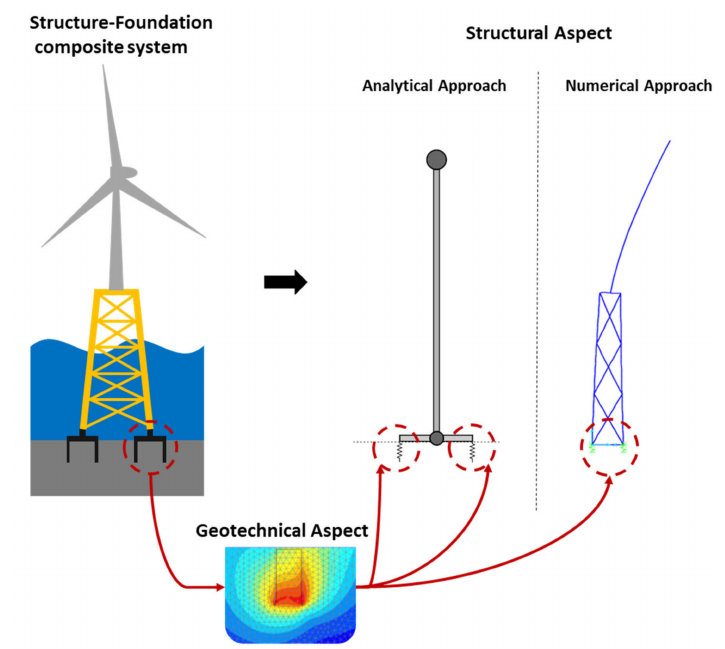
Figure 4. Breakdown of the structure-foundation